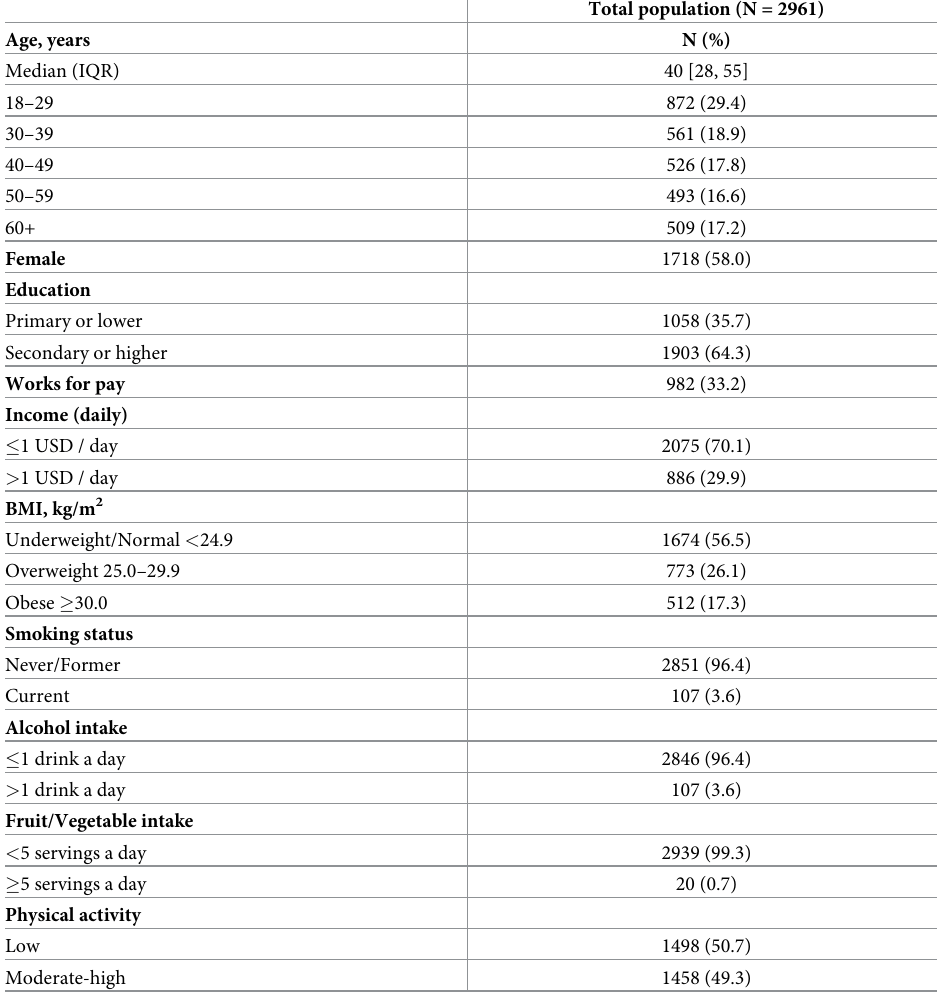
Table 1. Sociodemographic characteristics of Haitian adults in the Haiti CVD cohort study (N =